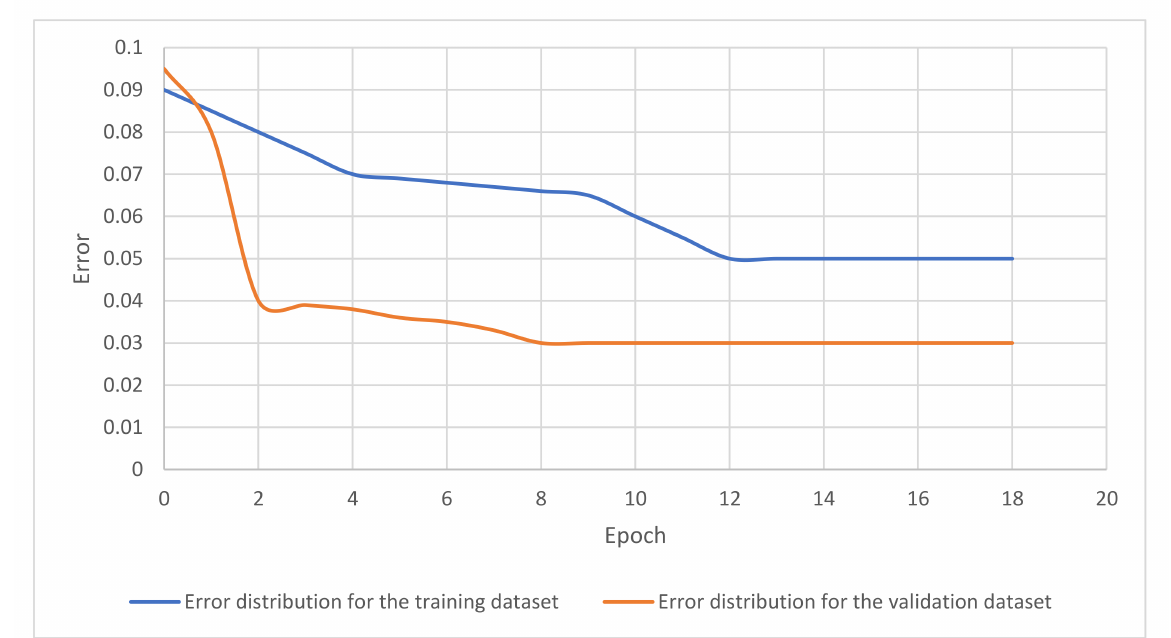
Figure 6. Network learning error distribution, own study.